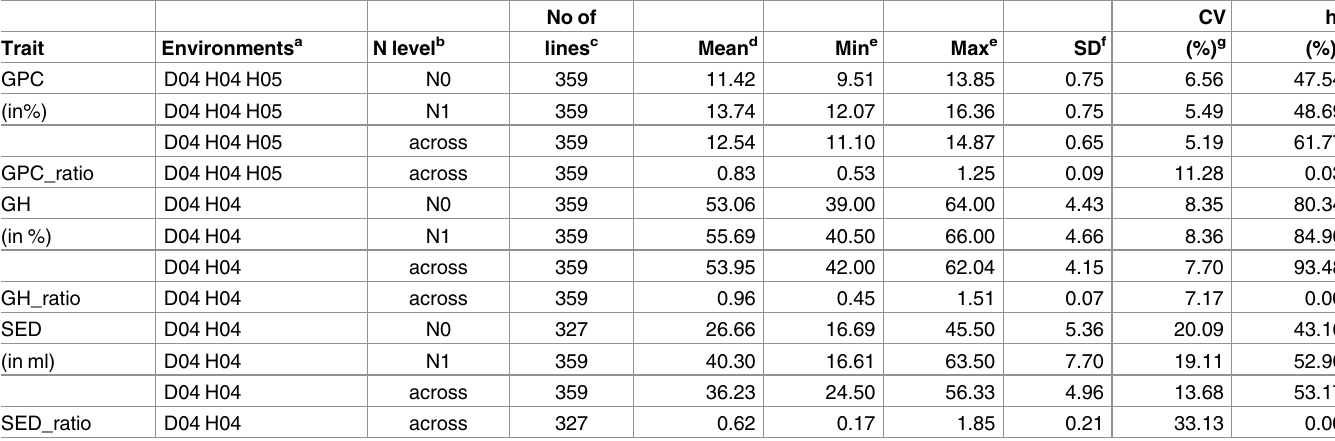
Table 2. Trait performanceof SW84 calculated across N levels and within N level, respectively. No of h